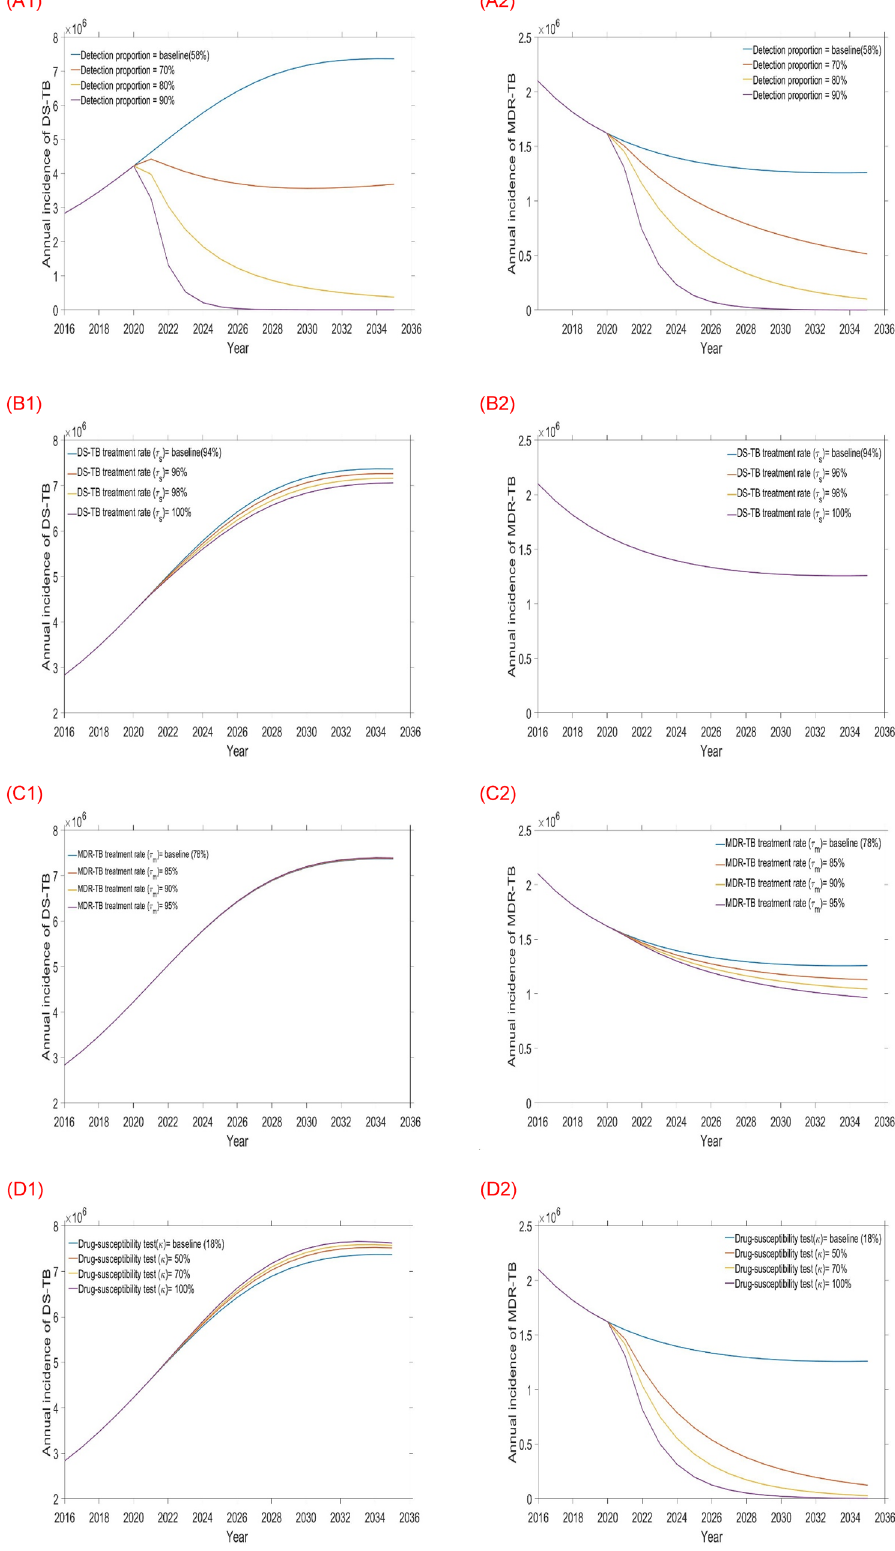
Figure 5. Impact of the four single intervention strategies on TB burden (left-hand side DS-TB annual incidence and right-hand side MDR-TB annual incidence): ( A1 and A2 ) varying detection rate, ( B1 and B2 ) varying DS-TB treatment rate, ( C1 and C2 ) varying MDR-TB treatment rate, and ( D1 and D2 ) varying Drug- susceptibility testing